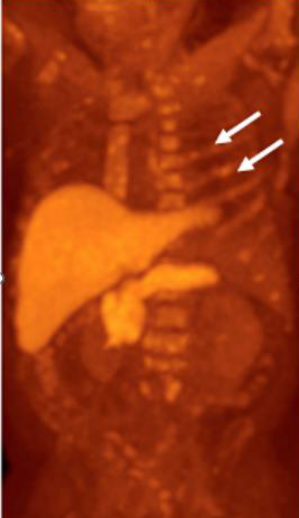
Figure 10. Sixty-seven-year-old male with history of prostate cancer, status post-prostatectomy, now presenting with rising PSA. Axumin MIP image shows multifocal Axumin uptake involving the axial and appendicular skeleton. The heterogeneous and discontinuous pattern of uptake (arrows) favors widespread metastatic disease over a benign diffuse bone marrow process such as treatment- related changes.